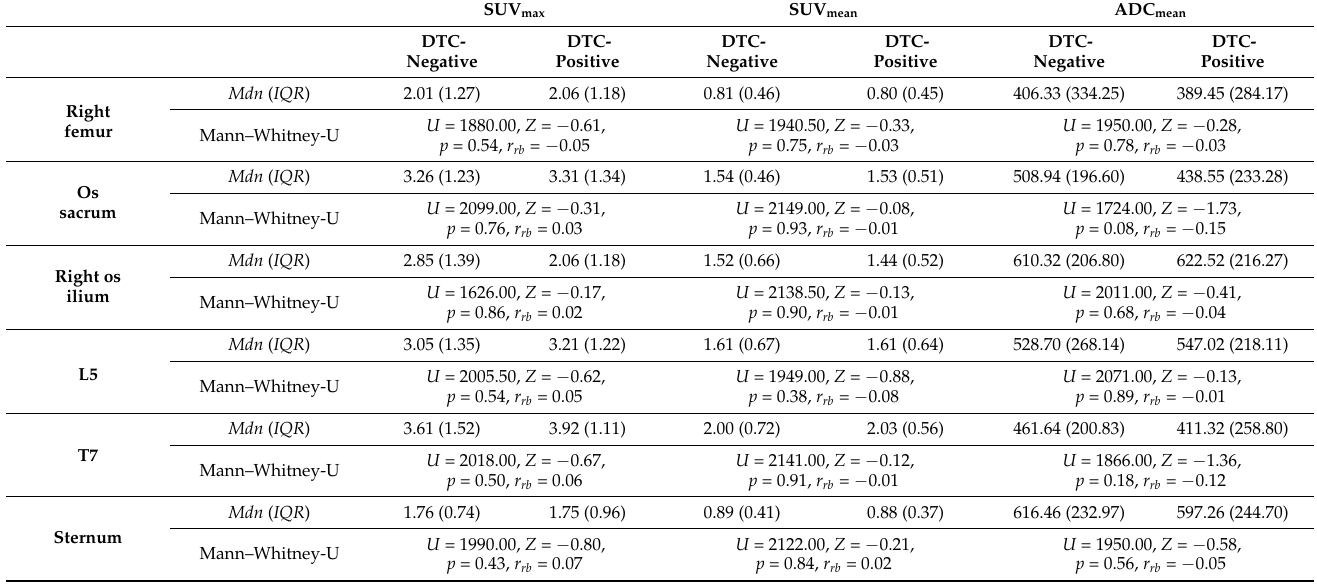
Table 3. Comparison of SUV max /SUV mean /ADC mean values derived from defined BM regions at [ 18 F]FDG-PET/MRI between DTC-positive and DTC-negative patients using Mann–Whitney-U test. Descriptive group statistics (median ( Mdn), interquartile range ( IQR )) and results of Mann– Whitney-U test are visualized.